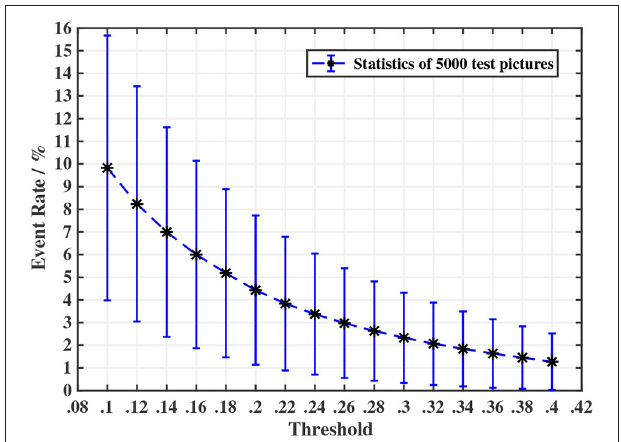
FIGURE 4 | A preparatory experiment for determining the threshold in ODG. We observed that the event rate shows a trend of an exponential decrease in the threshold. In consideration of the event rate of generated samples and to avoid generating too many invalid samples that have an extremely low event rate, we choose threshold = 0.18.